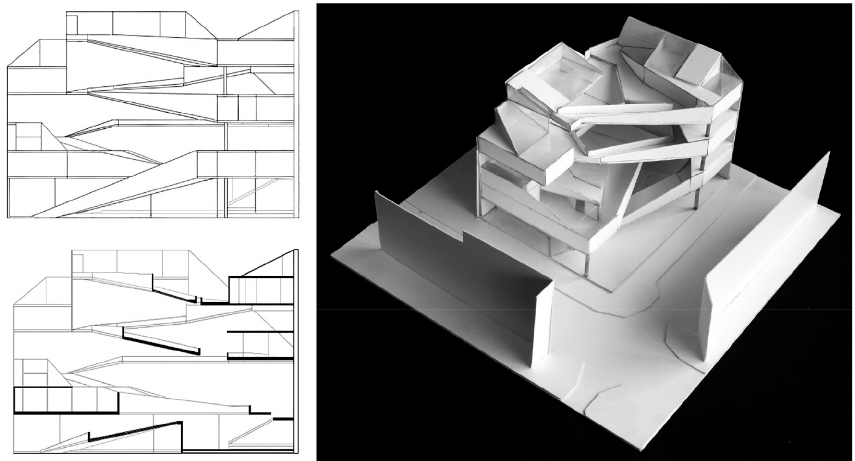
Figure 2. Not without my uncle. Student: Esther Caballú